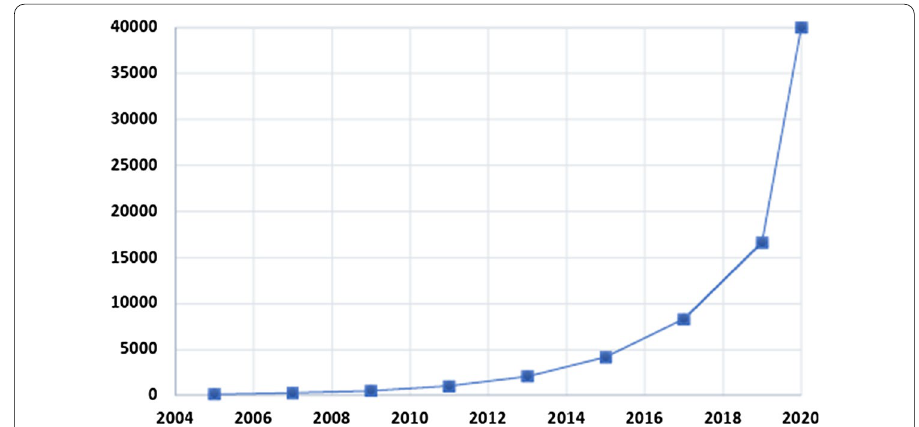
Fig. 2 Growth of digital data between 2005 and 2020 in exabytes. This figure shows the exponential increase in data volume according to the